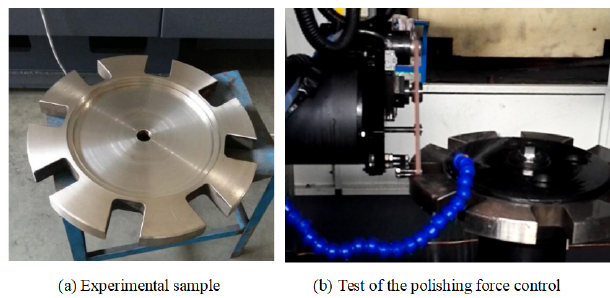
Figure 12. Experimental sample and drawing of the polishing force control